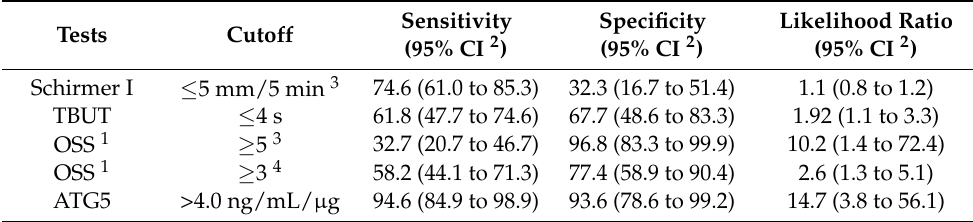
Table 4. Criterion values and coordinates of the ROC curve for tear ATG5 and ocular tests cur- rently